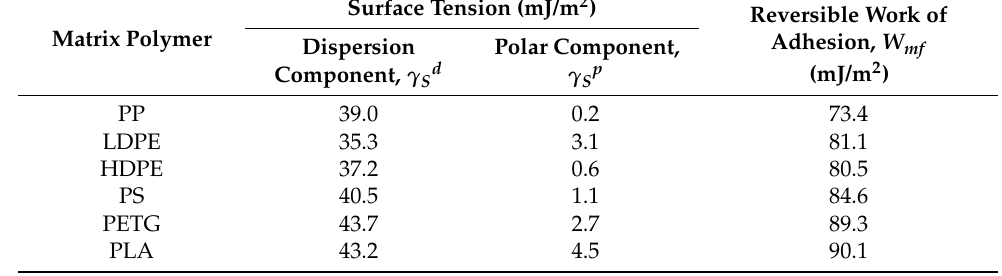
Table 4. The dispersion and polar surface tension components of the polymers used in the study, and the reversible work of adhesion in their composites.